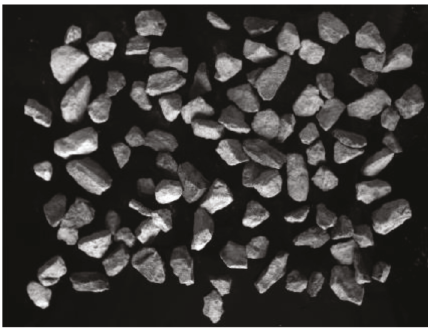
Figure 7: Improve the threshold function to process high-fre- quency coefficients.